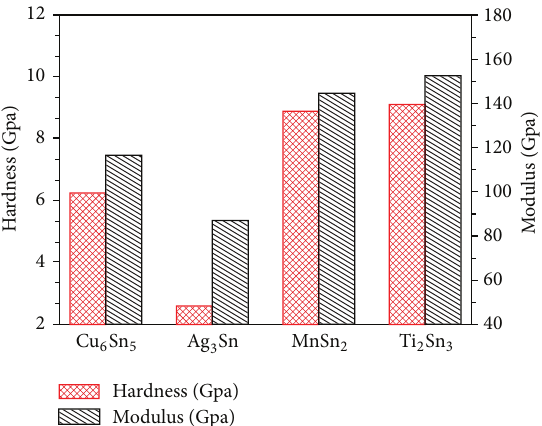
Figure 5: Nanoindentation results of the intermetallic phases [8].